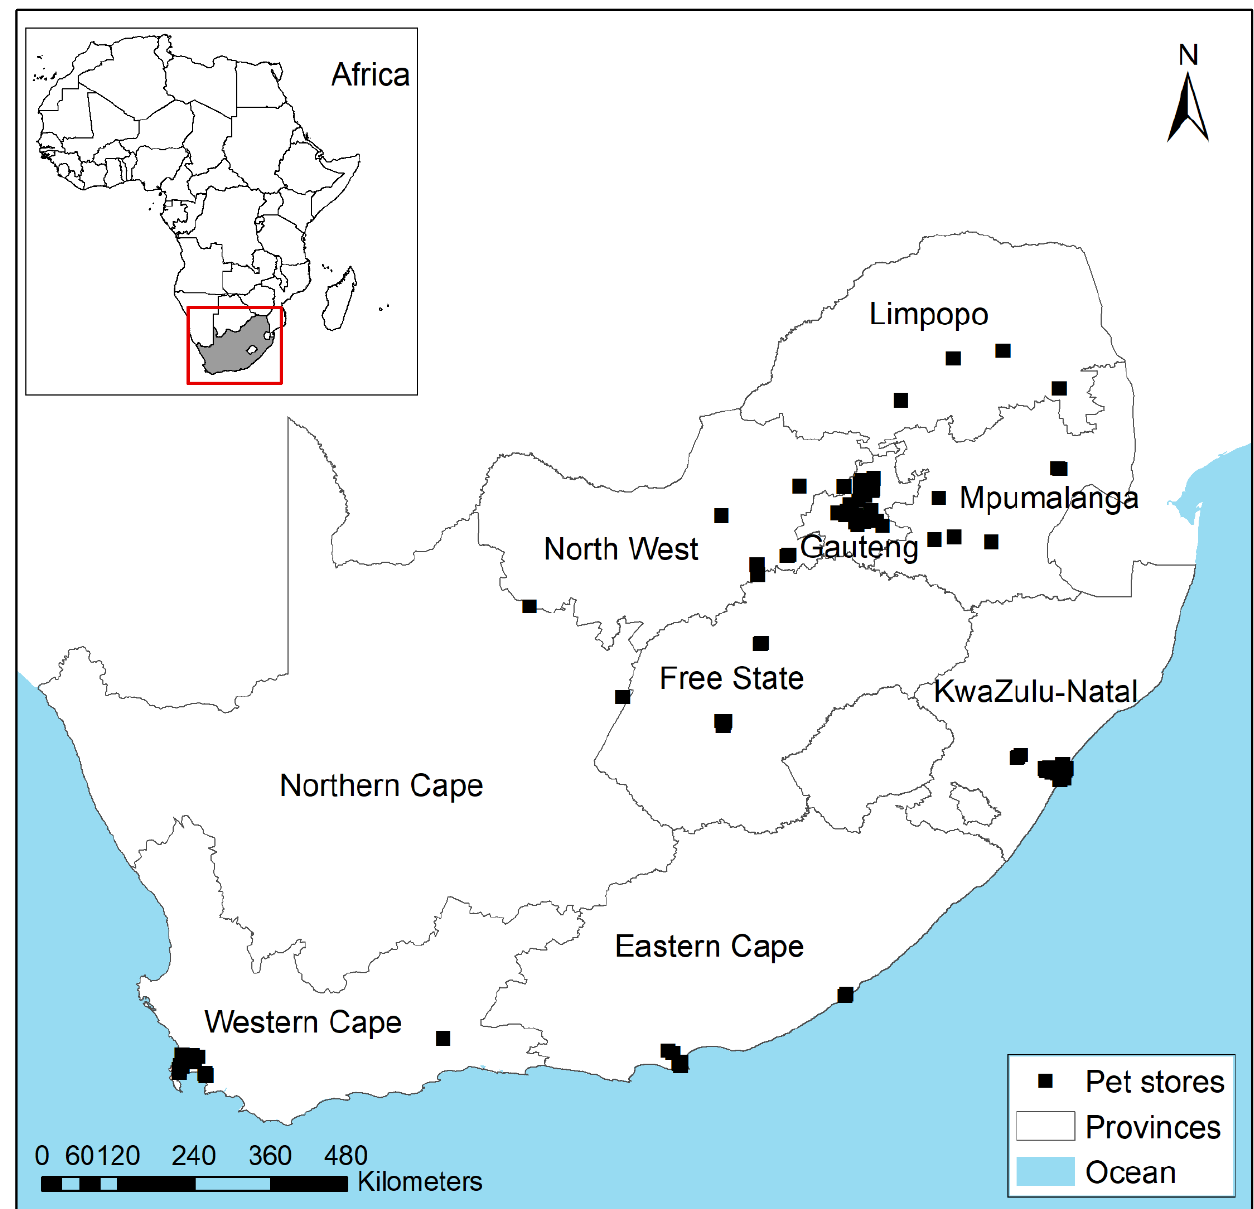
Figure 1. A map showing localities of pet stores where non-native mammalian species were recorded sold in South Africa between September 2018 and September 2019 (data from Shivambu et al. [48]).